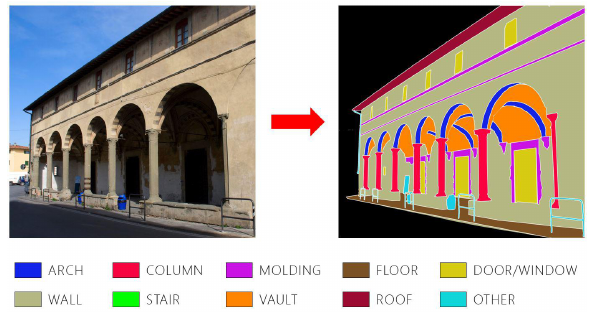
Figure 3 . Segmented image according to the ARCHdataset